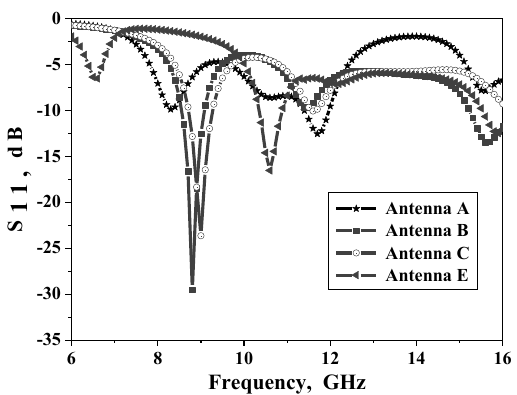
Fig. 3. The different geometric shapes of the radiation element